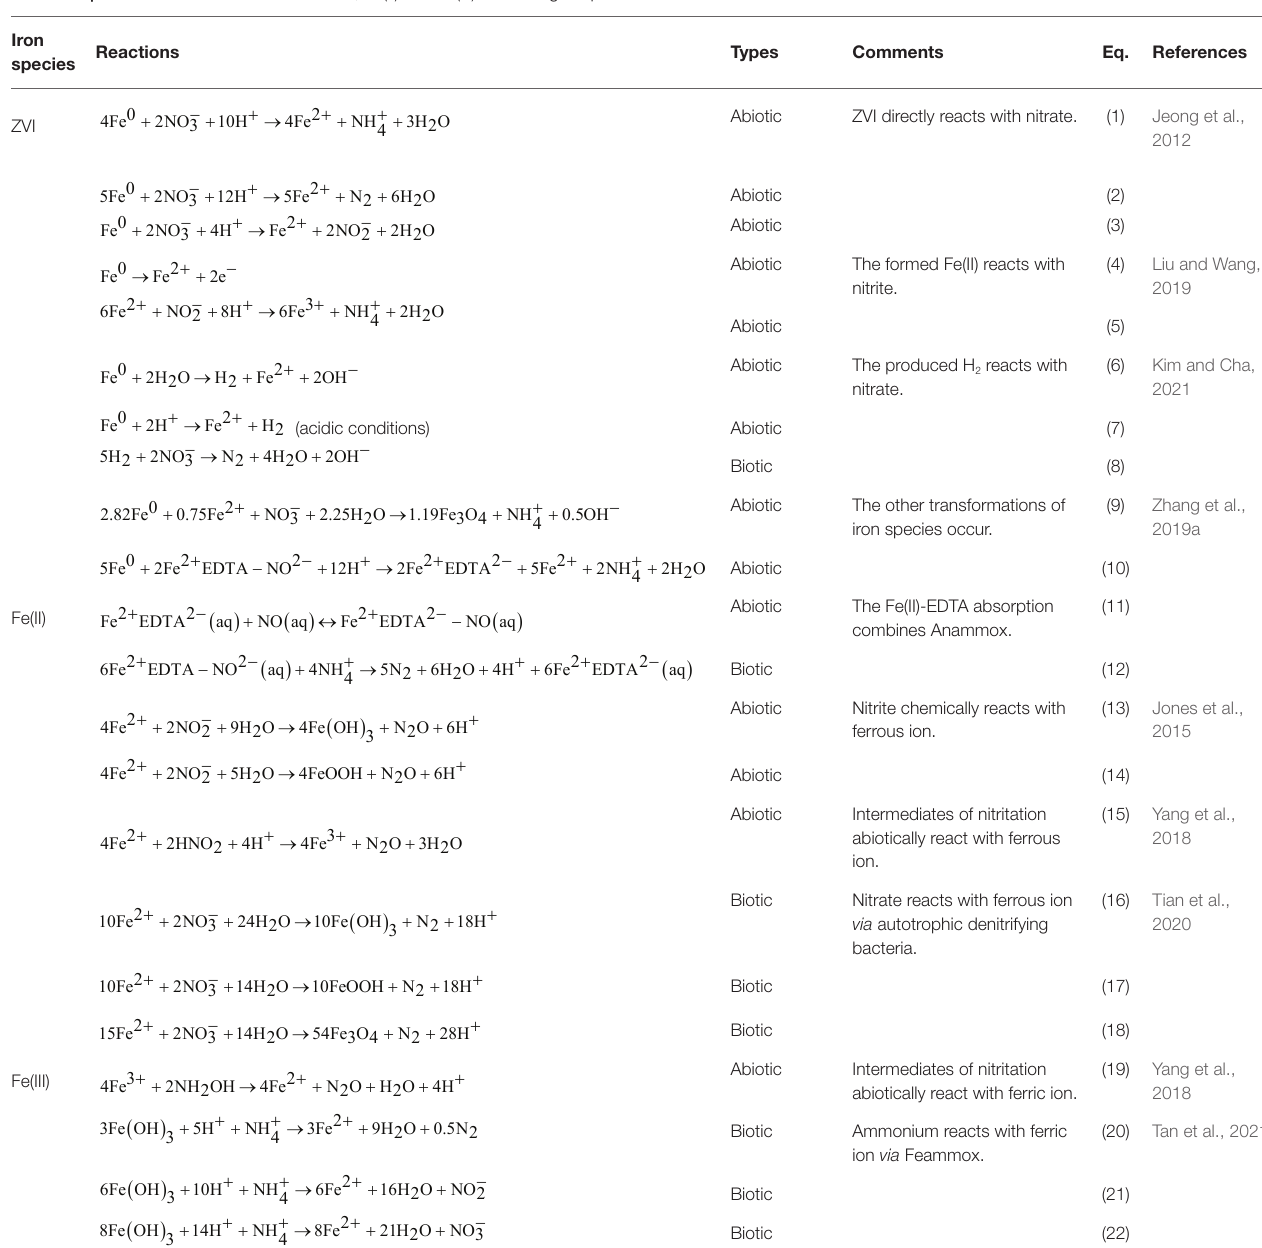
TABLE 1 | Abiotic and biotic reactions of ZVI, Fe(II) and Fe(III) with nitrogen